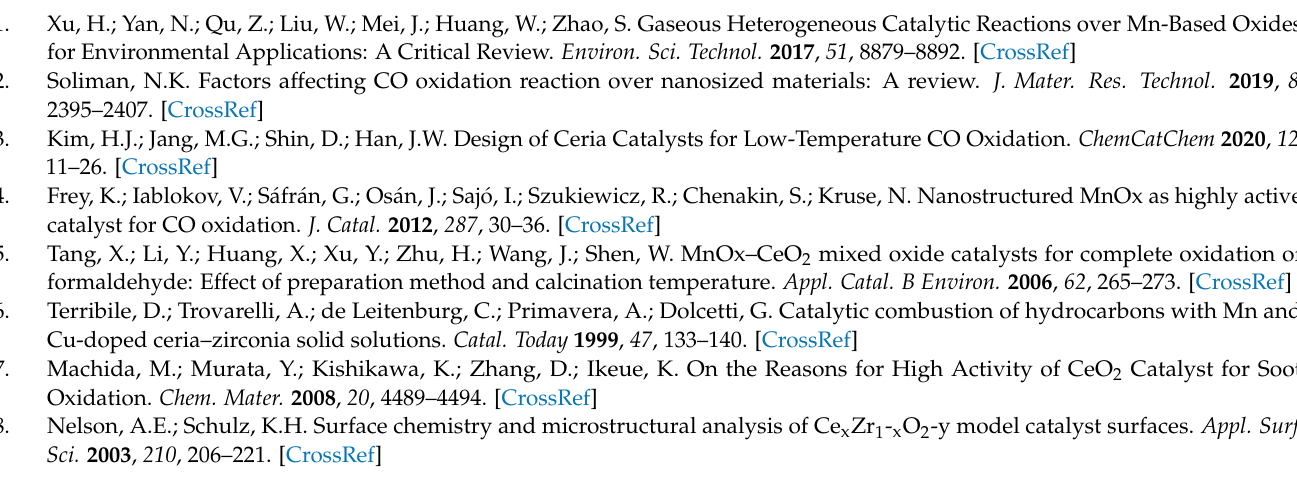
Figure S7: Temperature of 50% C 3 H 8 conversion versus the content of Mn (x) in Mn x Ce y Zr 1-x-y O 2 solid solution for all catalysts; Table S1: List of catalysts; Table S2: Phase composition of